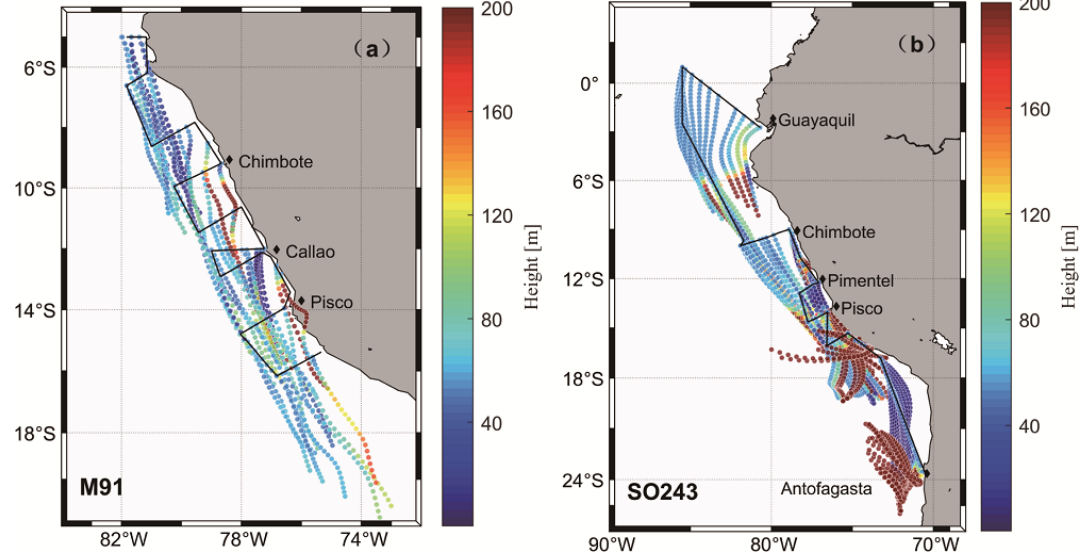
Figure 6. Air mass backward trajectories of cruise M9 (a) and SO243 (b) , with the colour bar indicating the height above sea level. Note that both scales are capped at 200m to ensure readability of the plots, despite that some values exceed the upper